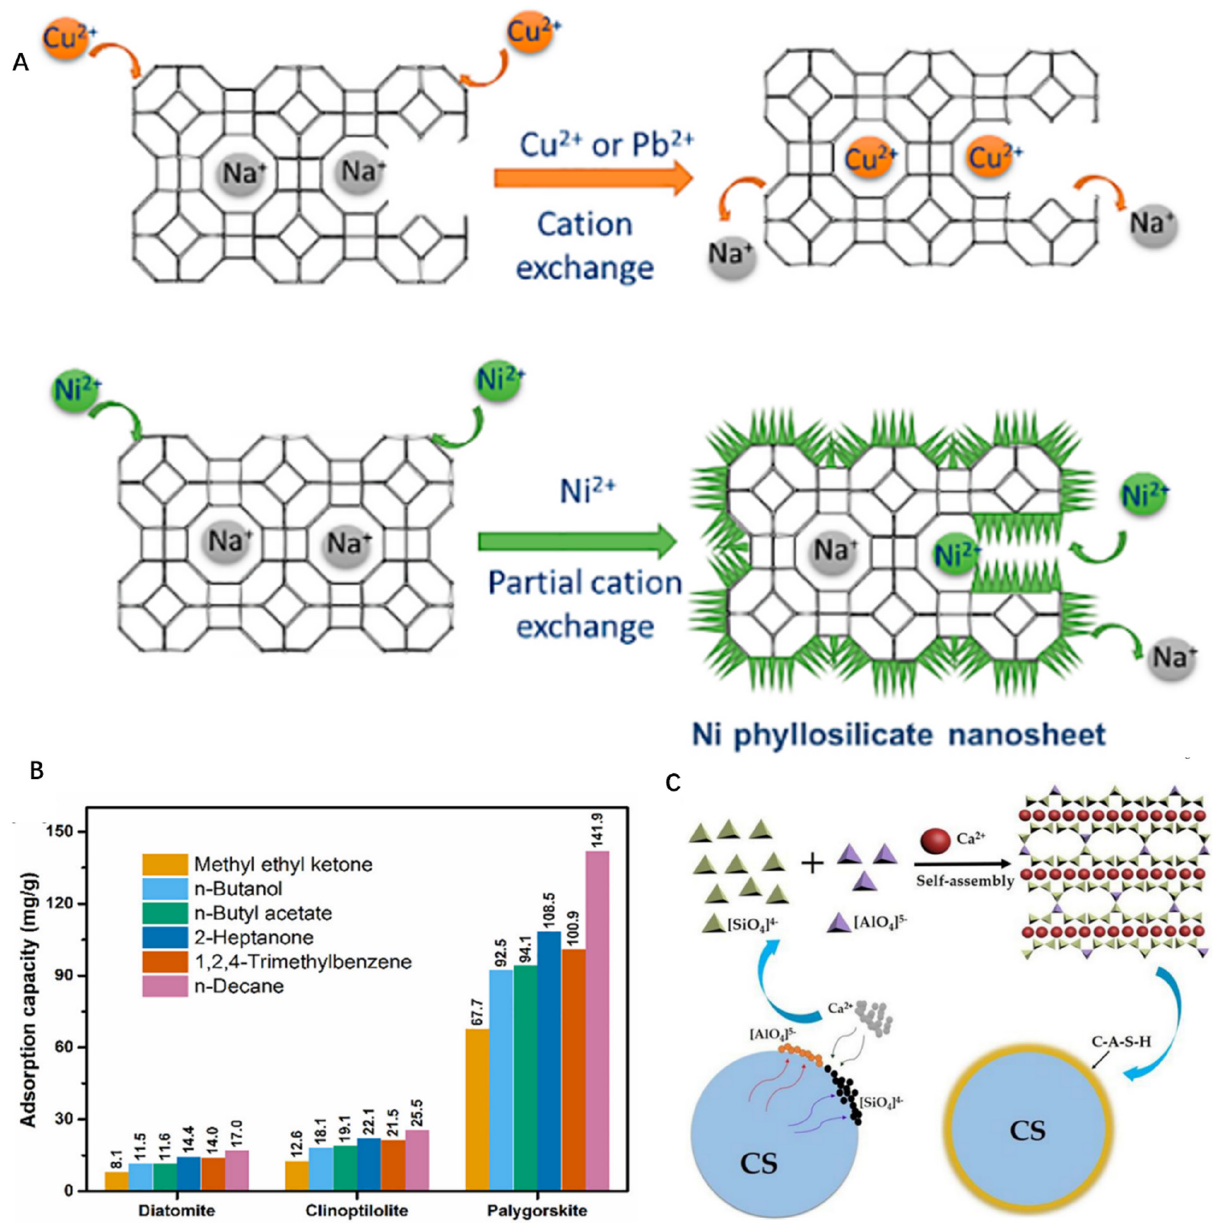
Figure 6. ( A ) Adsorption of heavy metals by zeolite, copyright 2018 Elsevier B.V. ( B ) Adsorption capacities of the diatomite, clinoptilolite, and palygorskite for VOCs, copyright 2019 Elsevier B.V. ( C ) Synthetic artificial self-assembly minerals, copyright 2018 Elsevier B.V.